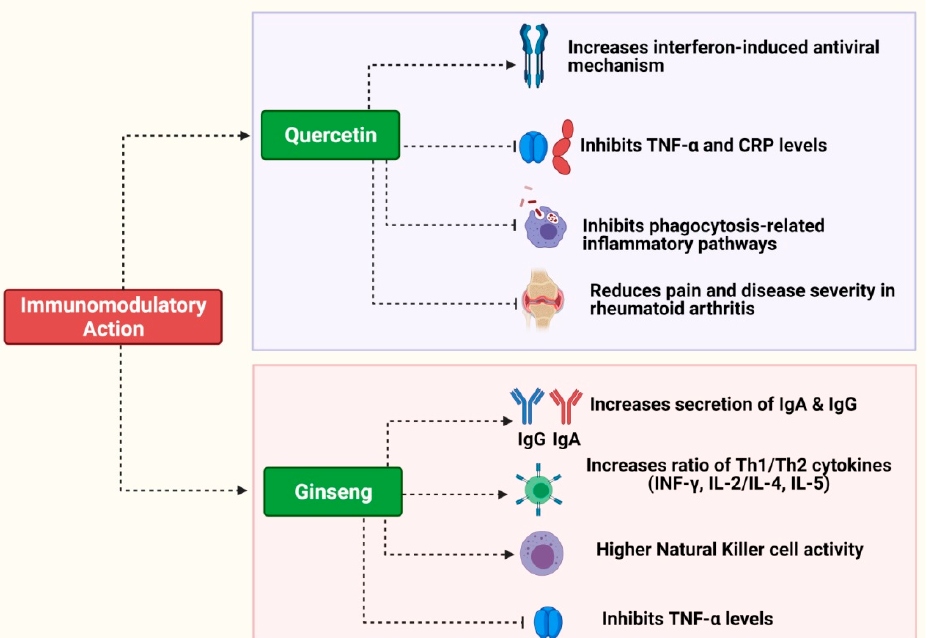
Figure 2. Immunomodulatory activities of quercetin and ginseng.